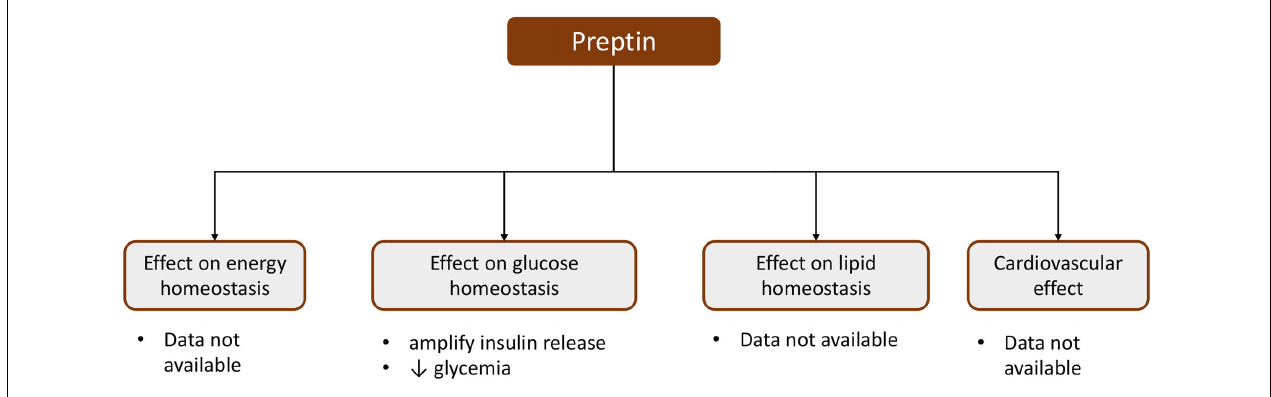
FIGURE 2 | Schematic presentation of the effect of